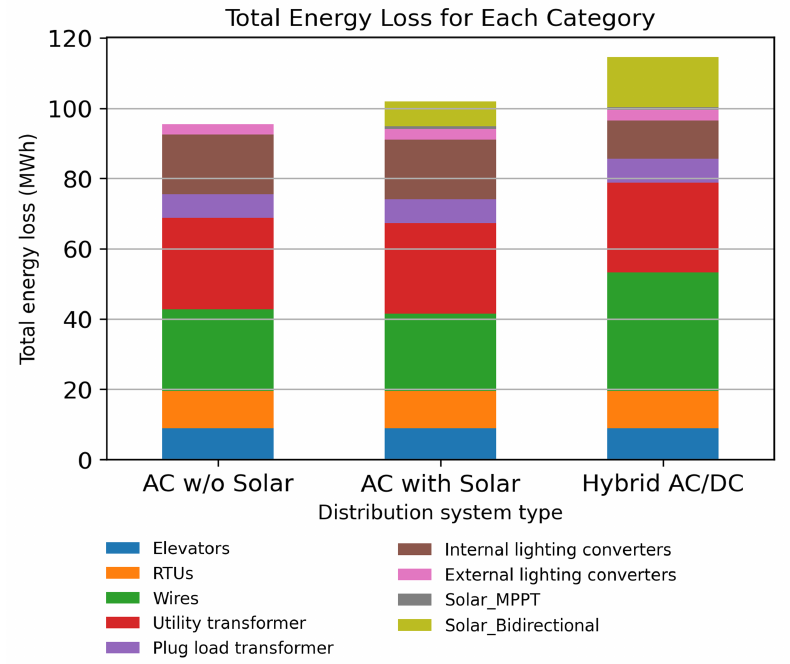
Figure 10. Whole-year loss comparison for the three building electrical distribution